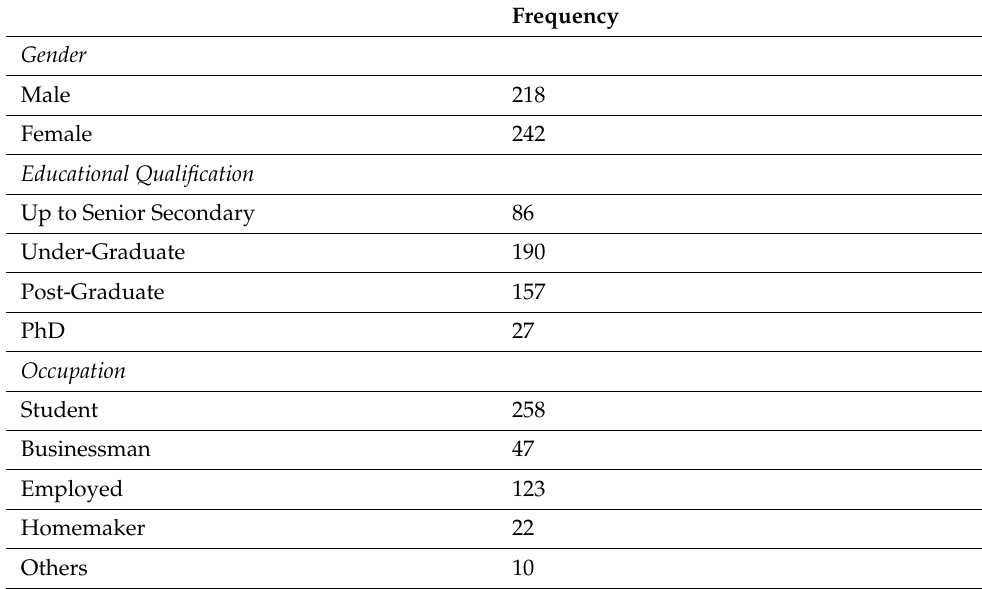
Table 1. Demographics of 460